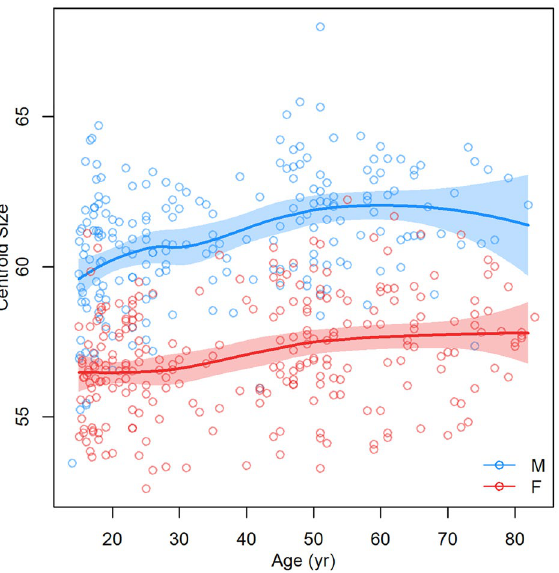
Figure 2. Dependence of facial centroid size on increasing age (the function was constructed separately for females and males as curves with a 95% confidence region).